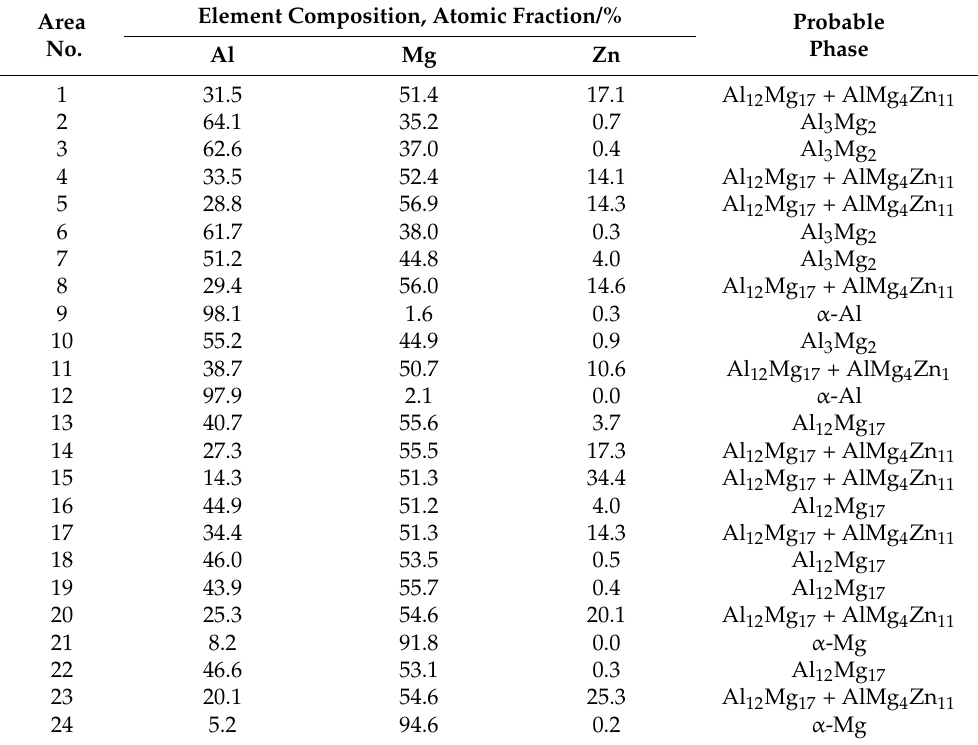
Table 5. EDS point scanning analysis of composite plate section in different rolling